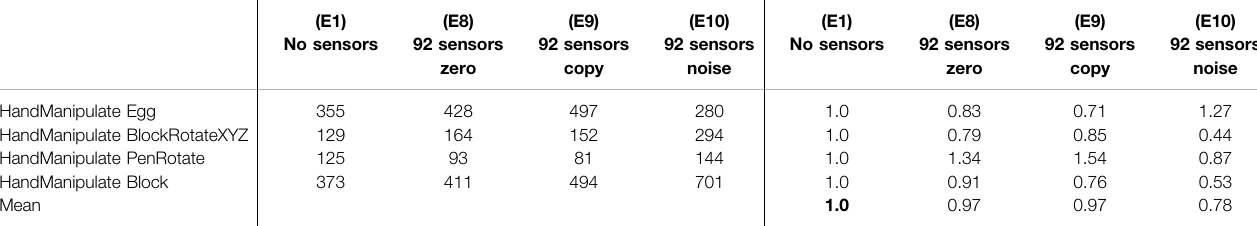
TABLE 7 | Experiments E8 – E10 ( Figure 6 ): Convergence Epoch (columns 2 – 5) and Convergence-Epoch Ratio (columns 6 –